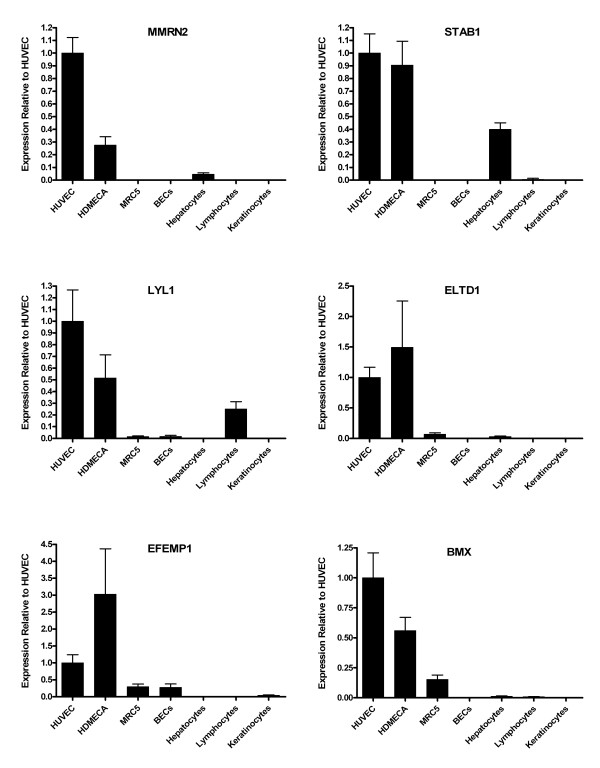
Real time PCR analysis of randomly chosen endothelial predicted genes across a range of cell types. Real time PCR was carried out on predicted endothelial genes MMRN2, STAB1, LYL1, ELTD1, EFEMP1 and BMX. The graphs illustrate the power of the bioinformatics models as all genes examined were up regulated or specific to HUVECs and/or HDMECs.